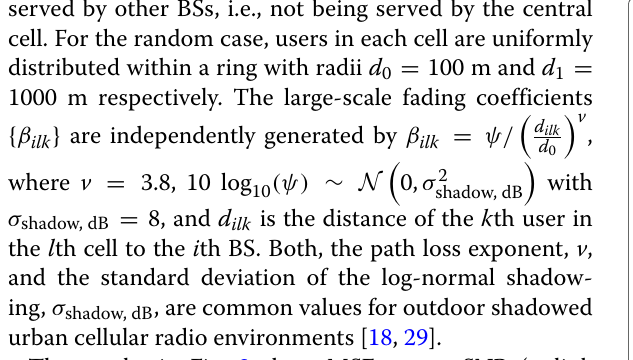
Figueiredo etal. EURASIPJournalonWirelessCommunicationsandNetworking (2018) 2018:14